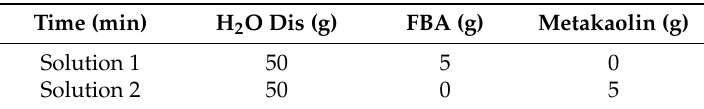
Figure 2. SEM micrographs of FBA at different magnifications. Table 3. Solution proportions.